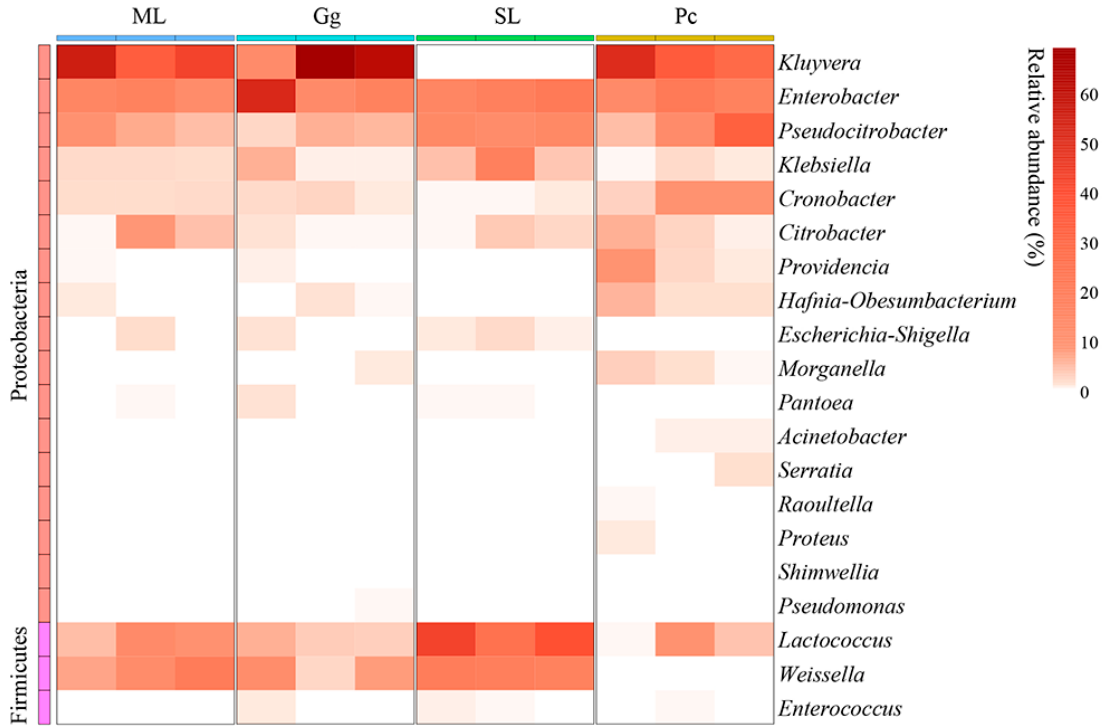
Figure 5. Clustering heat map of the 20 most abundant genera in the gut bacterial community of Locusta migratoria manilensis fed on four different food plants. ML: maize leaves; Gg: goosegrass; SL: soybean leaves; Pc: pakchoi.